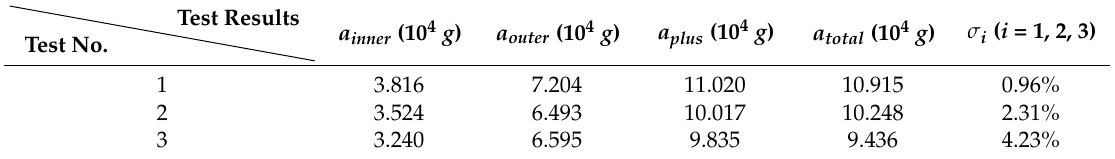
Table 2. Peak accelerations of a inner , a outer , a plus , a total , and the dynamic linearities of the impact system.